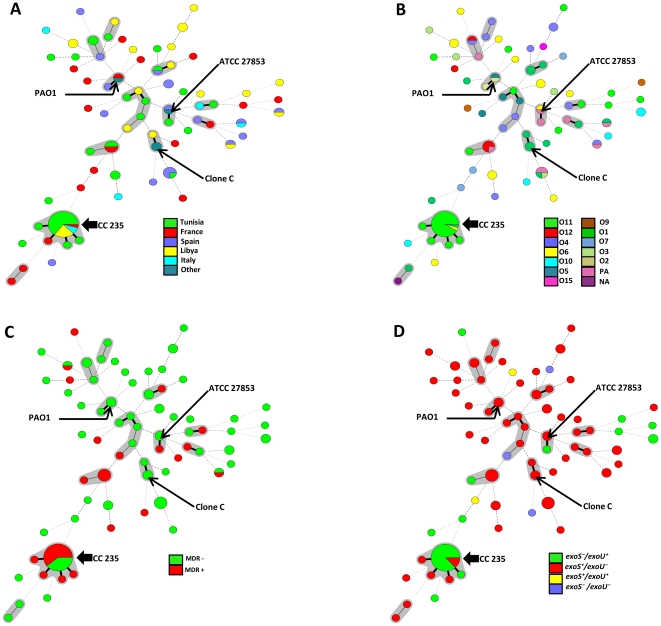
Minimal Spanning Tree (MST) analysis of Pseudomonas aeruginosa strains based on MLST data.Each circle corresponds to an ST. The area of each circle corresponds to the number of isolates. The relationships between strains are indicated by the connections between the isolates and the lengths of the branches linking them. Black lines connecting pairs of STs indicate that they differ in one allele (thick lines), two alleles (thin), or three to seven alleles (dashed). Grey zones surround STs that belong to the same clonal complex (clonal complex were defined from this collection, and CC235 was the predominant). Four MST graphs were generated separately based on the following associations. A: ST vs countries, B: ST vs serotype, C: ST vs multidrug-resistance and D: ST vs exoS/exoU.